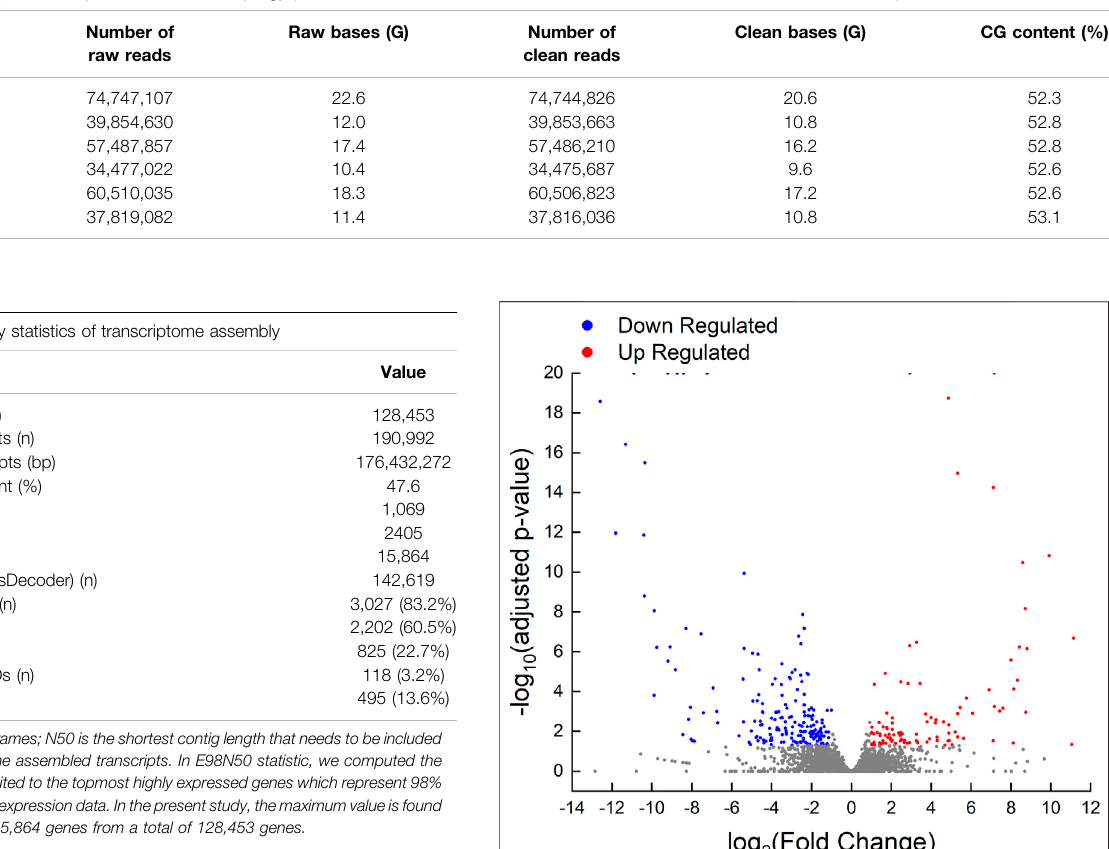
TABLE 3 | Overview of functional annotation using eggNOG mapper v2 Database Number eggNOG